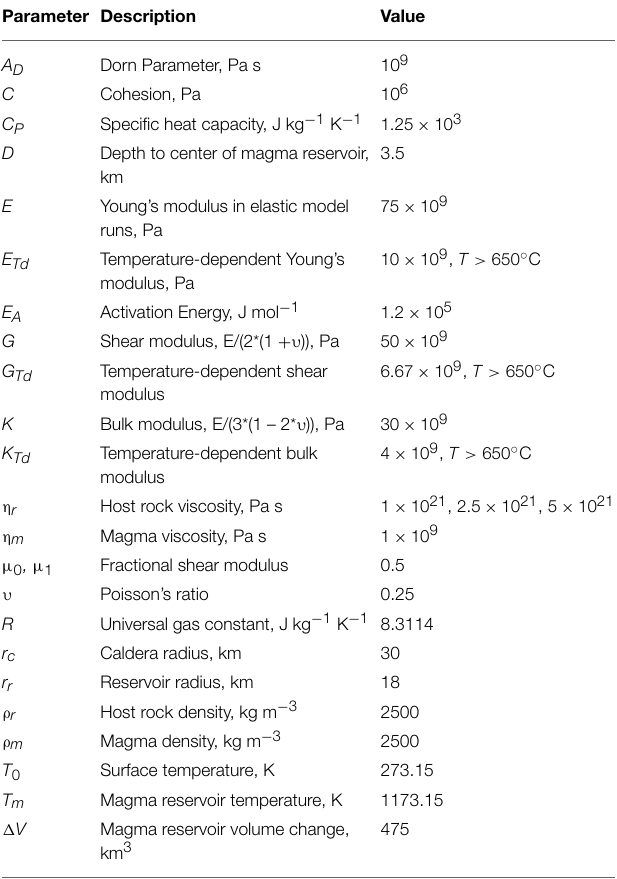
TABLE 3 | Model parameters used in applying the Gregg et al. (2012) thermomechanical approach to this investigation of resurgence. Parameter